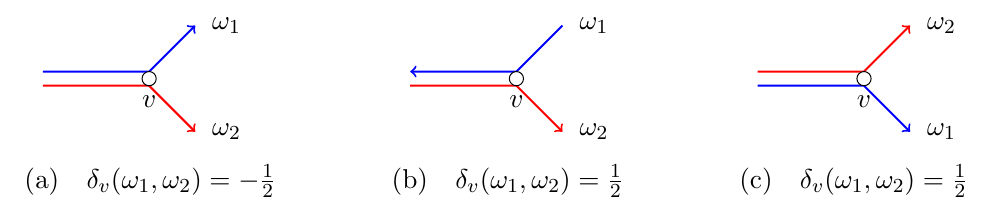
Figure 1. An illustration of (cid:14) v ( ! 1 ; ! 2 ). If ! 1 and ! 2 are in the counterclockwise order, and with the same direction, (cid:14) v ( ! 1 ; ! 2 ) = 1 as in (c). Any change in the clockwise order or direction gives 2 an extra sign, e.g., (a)(b). The arrows represent the orientations of the loops ! i .